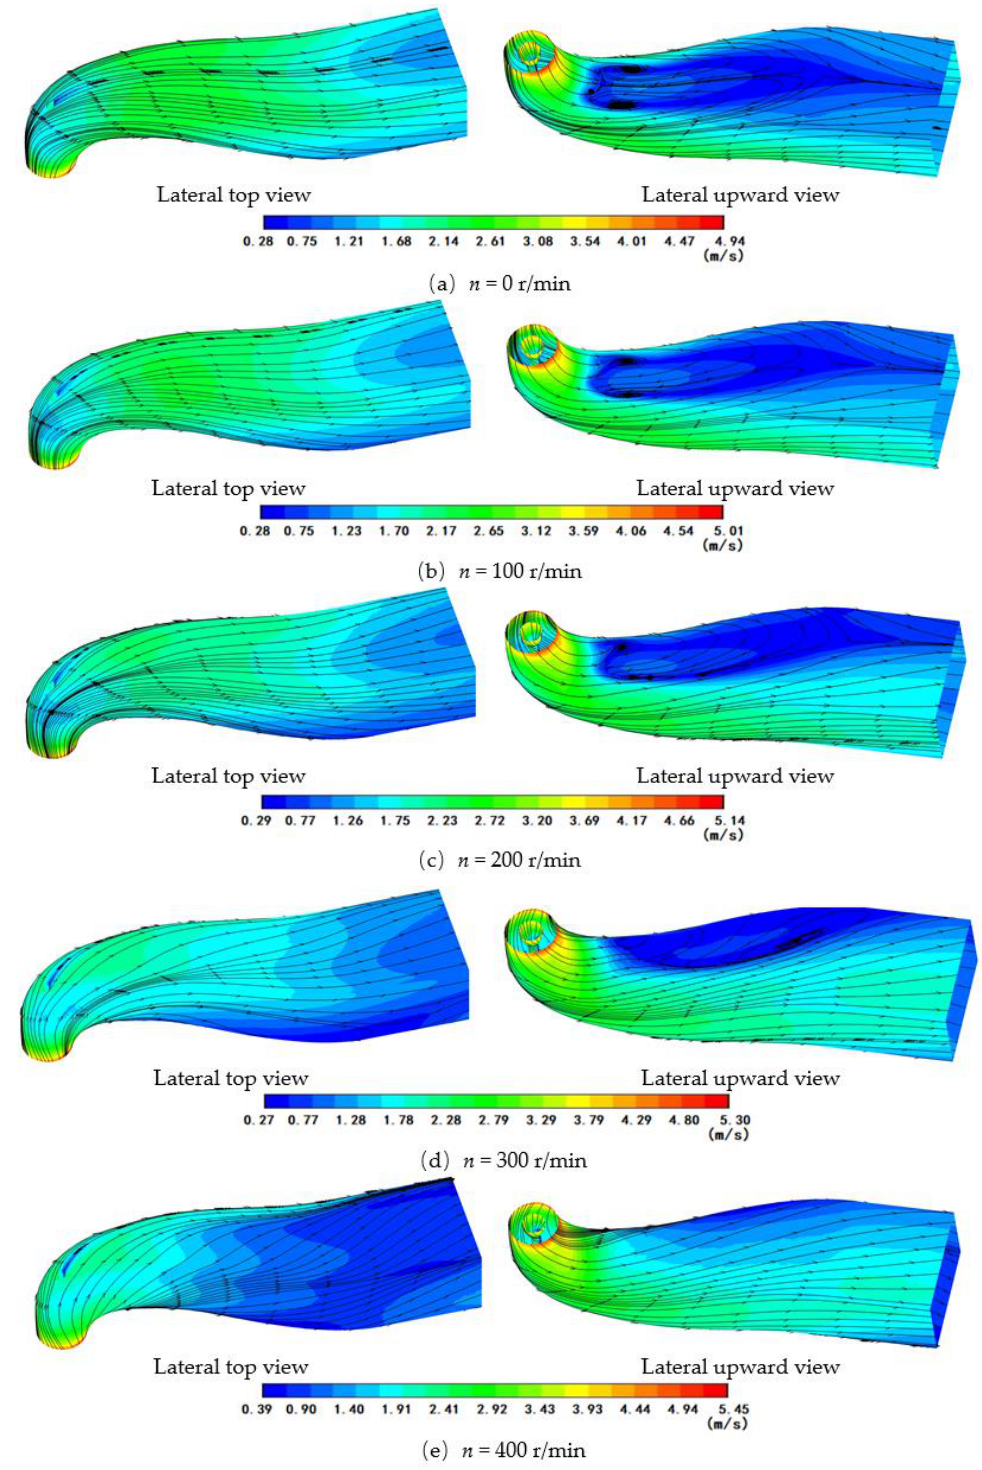
Figure 13. Flow field of low hump outlet conduit under different inlet water rotation speeds.